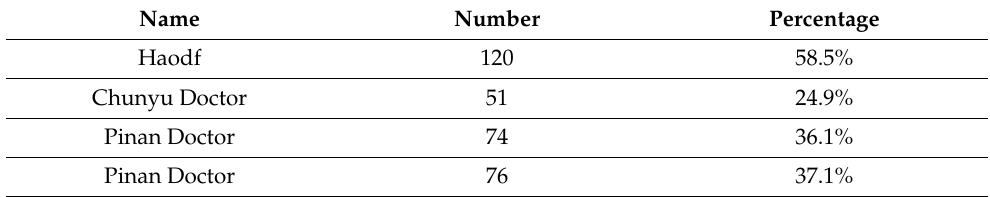
Table 2. Summary of online healthcare